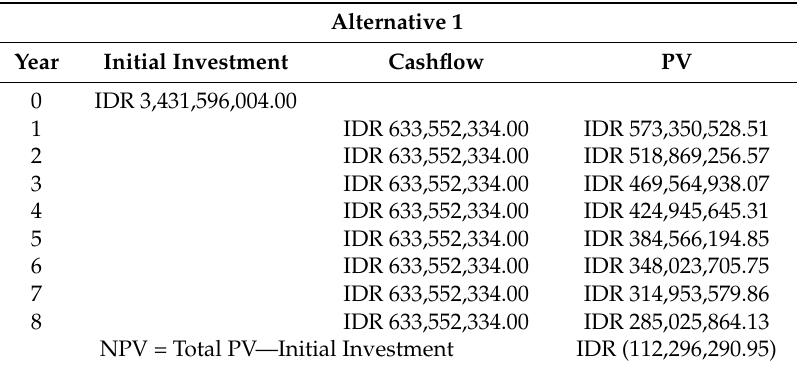
Table 10. NPV Calculation Result.